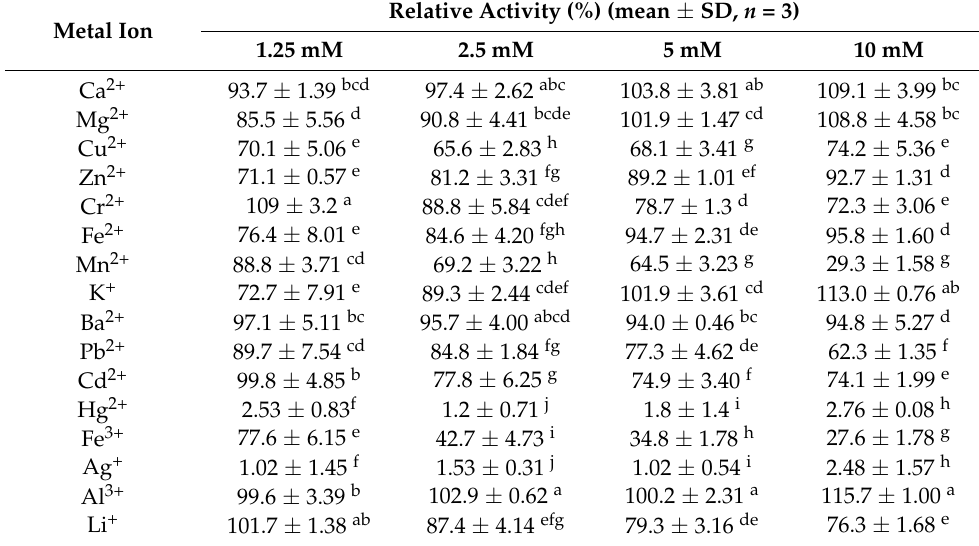
Table 3. The effects of metal ions on ORG. Metal